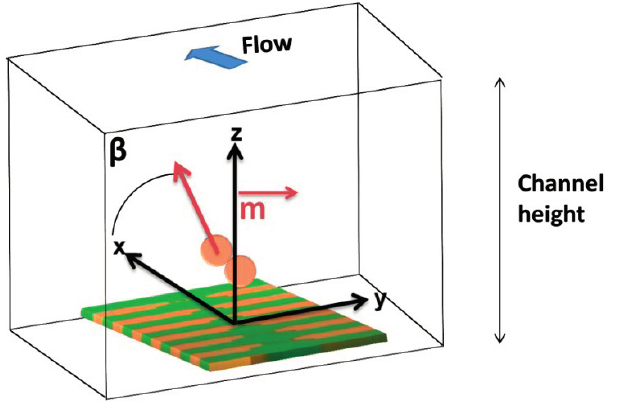
Figure 20. Schematics of axis and configuration considered for simulation in Mathematica 7.0 of the influence of both perpendicular and parallel components of fringe field in signal.